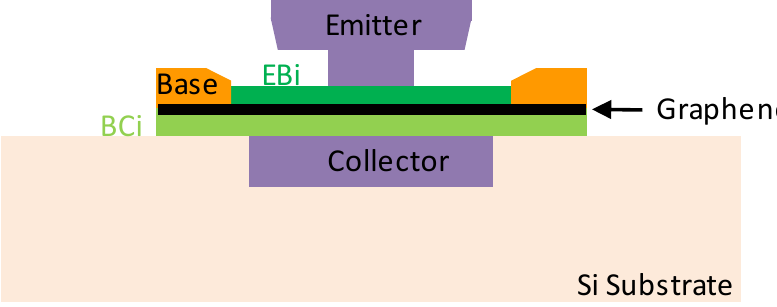
Figure 1. Schematic representation of the transistor